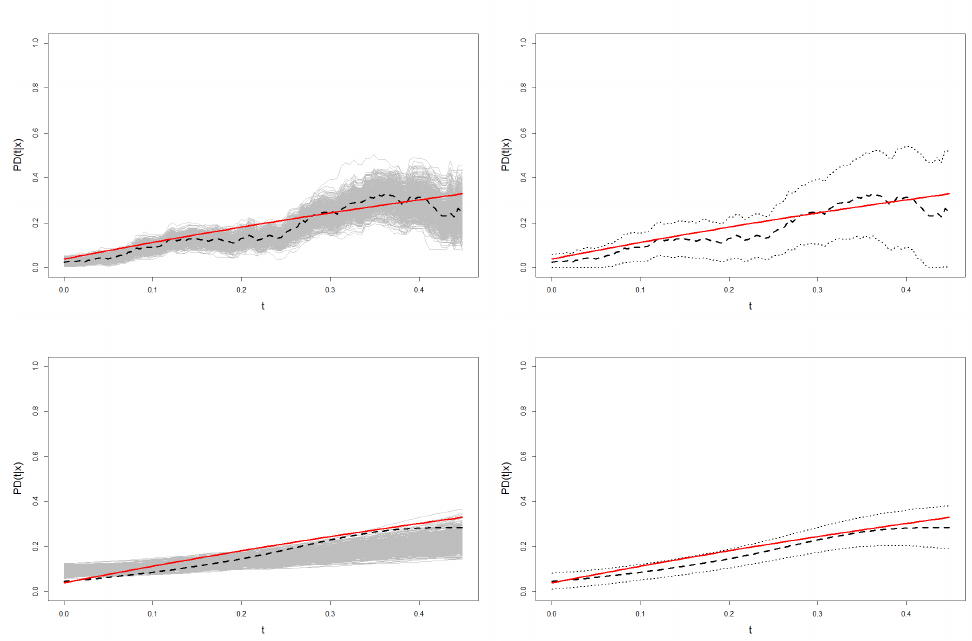
Figure 9. Theoretical PD ( t | x ) (red solid line) and estimation with MISE bandwidths (black dashed line) along with the bootstrap estimations of PD ( t | x ) from B = 500 resamples (gray dashed lines) in the left panel and 95% confidence region (black dotted lines) in the right panel by means of Beran’s estimator ( top ) and the smoothed Beran’s estimator ( bottom ) for one sample from Model 1 when P ( δ = 0 | x ) = 0.5.